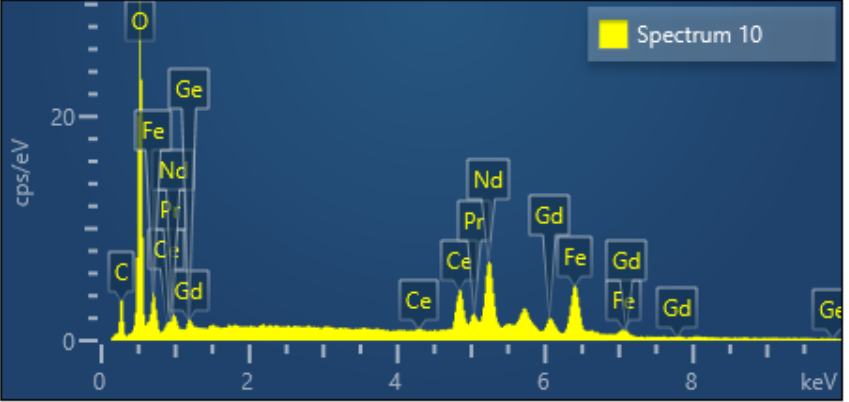
Figure 7. EDX analysis of certain particles after oxidation, containing mostly iron oxide (spectrum 9).